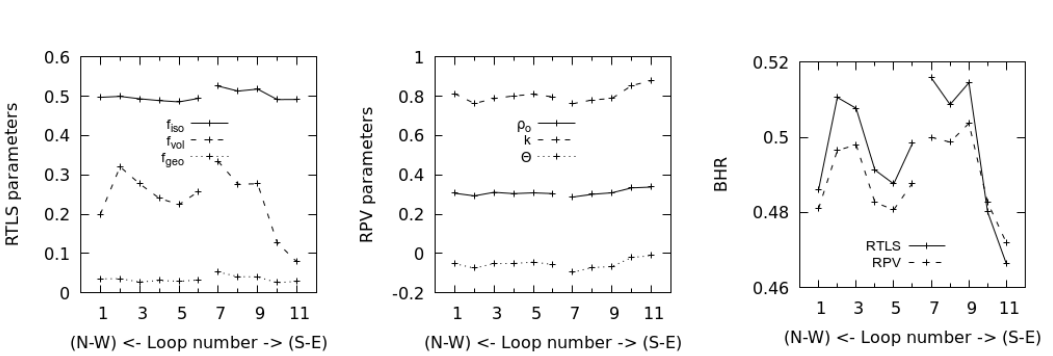
Figure 7. The RTLS ( left ) and RPV ( middle ) parameters for the red channel and the corresponding BHR values ( right ) as computed over two different RRV regions, obtained by CAR data taken on 16 May 2008. Flight altitude above ground level was ∼ 200 m for the S-E loops, and ∼ 650 m over the N-W